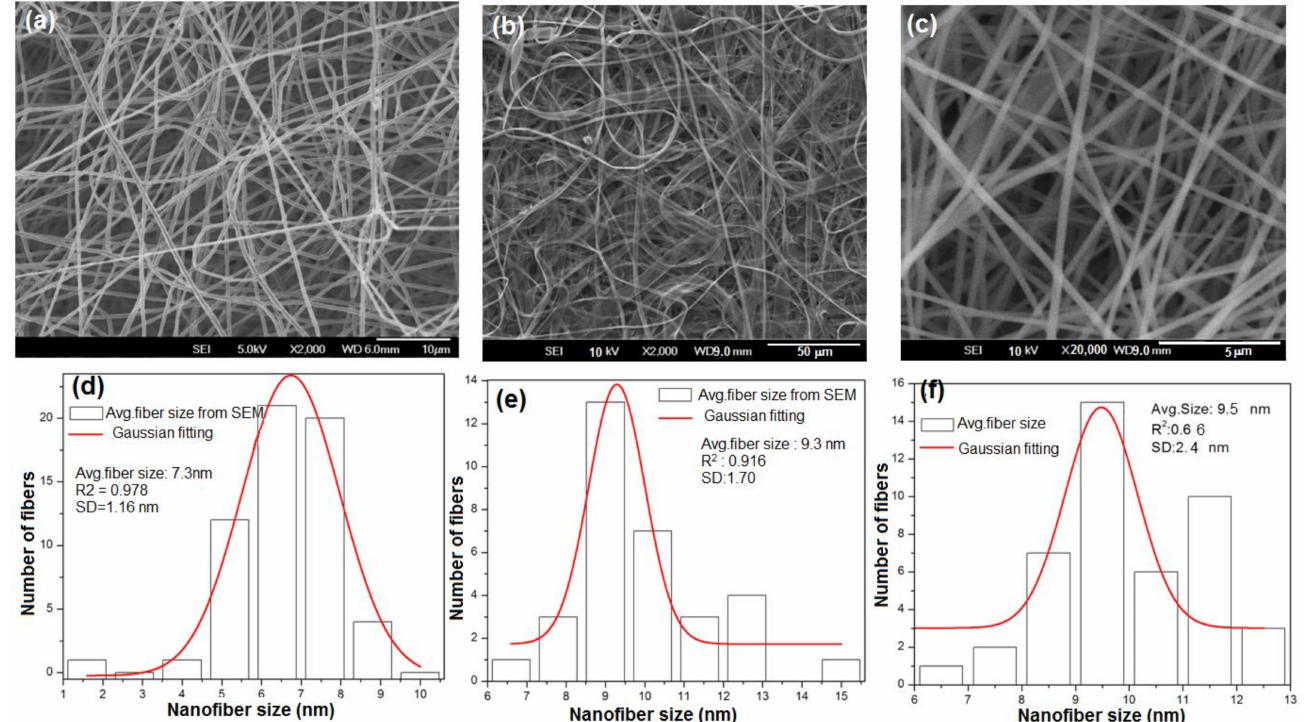
Figure 3. Surface morphology of the nanofibers after calcination at 575 ◦ C ( a ) TiO 2 nanofibers; ( b ) SnO 2 nanofibers; ( c ) composite TiO 2 -SnO 2 nanofibers; average fiber distribution; ( d ) TiO 2 nanofibers; ( e ) SnO 2 nanofibers; ( f ) composite TiO 2 -SnO 2